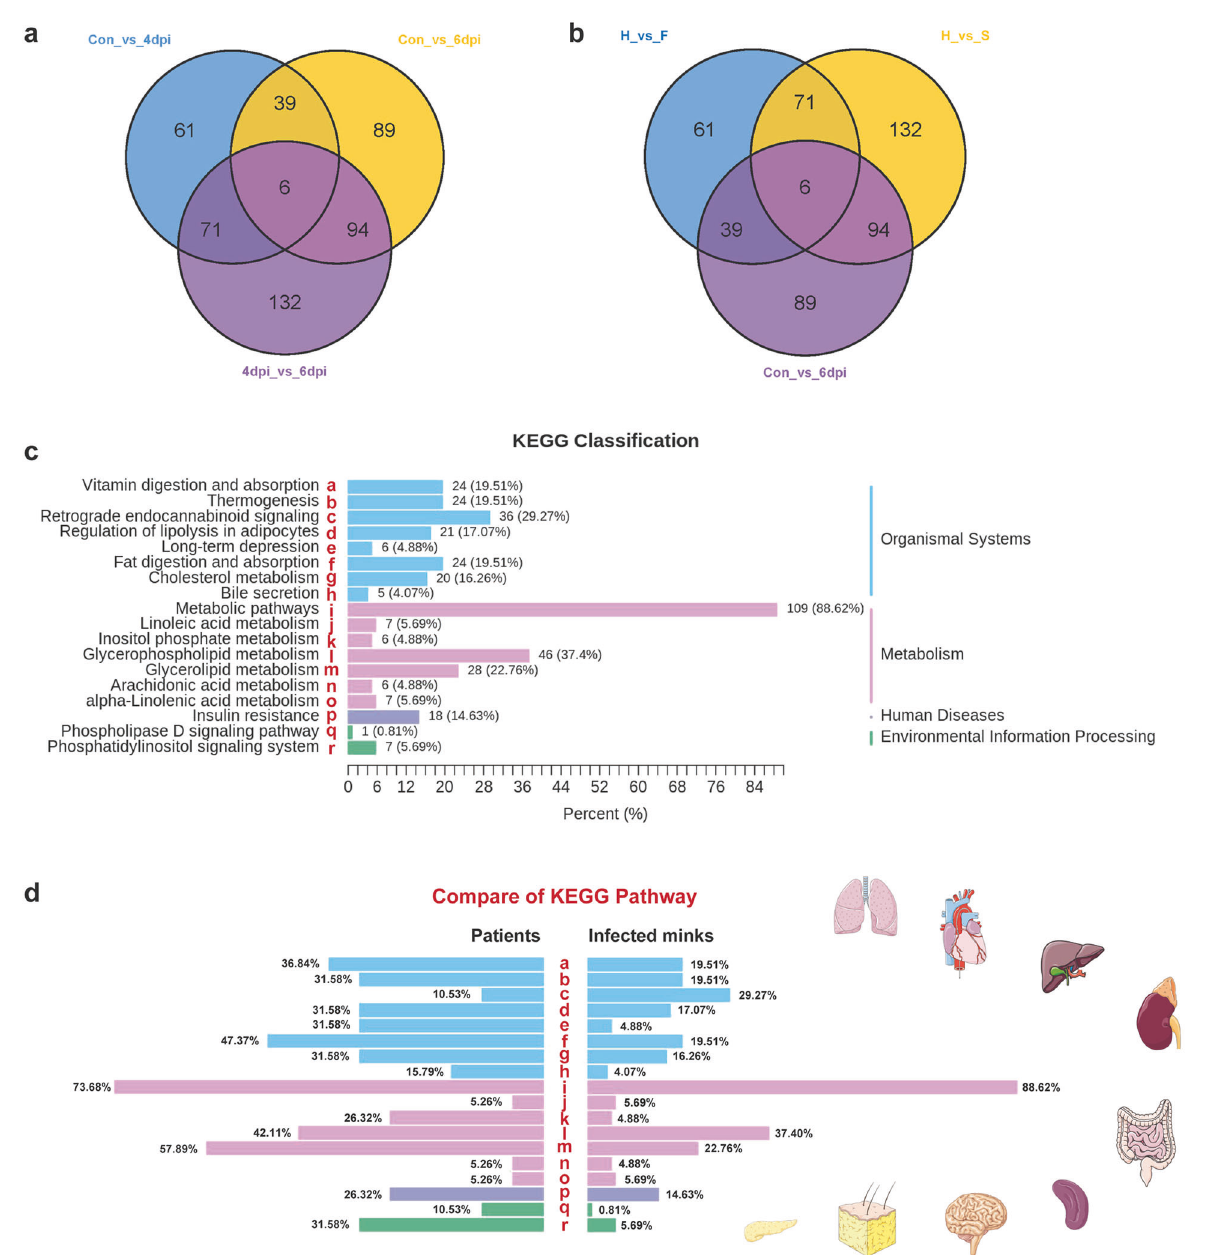
Fig. 4 Comparison of differential metabolites between infected minks and COVID-19 patients. a Venn diagram among control vs. 4 dpi, control vs. 6 dpi, and 4 dpi vs. 6 dpi groups in infected minks. b Venn diagram among healthy vs. deceased patients, healthy vs. severe patients, and control vs. 6-dpi group. c Metabolome KEGG enrichment analysis of serum from infected minks. KEGG pathway analysis of differentiating metabolites in 6 dpi. d Comparison of KEGG pathways between infected minks and COVID-19 patients. dpi days post infection, KEGG Kyoto Encyclopedia of Genes and